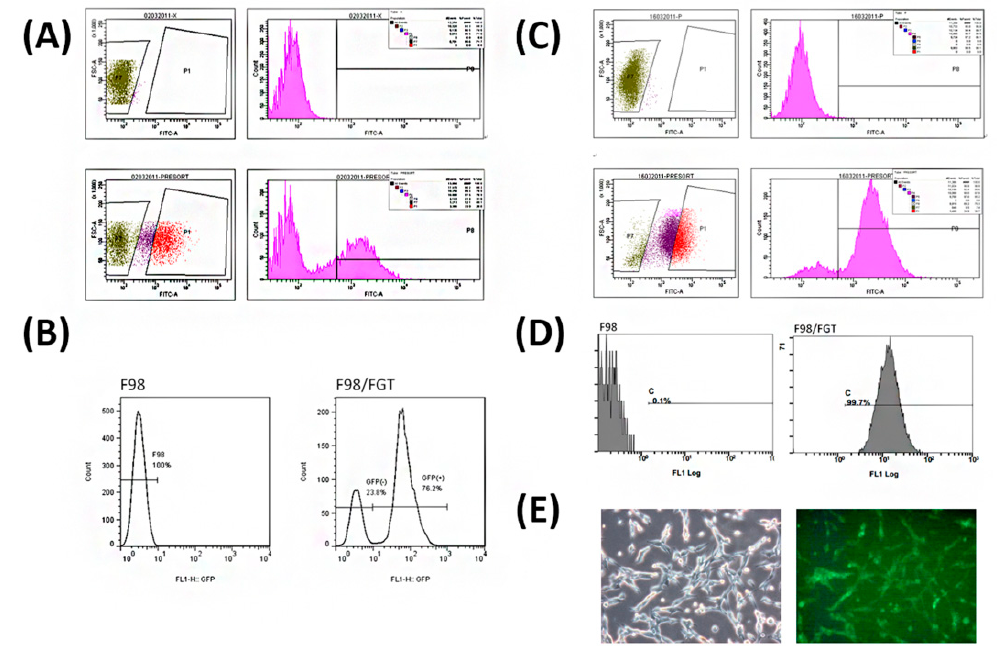
Figure 4. Further sorting of MOI-10 F98 / FGT cells using green fluorescent protein (GFP) reporter and FACScan flow cytometer (FCM) for selection. ( A ) Top left: parental F98 cells were used as the negative control to provide two regions using 2 × 10 5 as the cut-o ff point—P7 for parental F98 cells and P1 for high intensity of green fluorescent F98 / FGT cells. Top right: the green fluorescent intensity (i.e., FITC-A) of F98 parental cells was all less than 2 × 10 2 . Bottom left showed the P7 and P1 for F98 / FGT cells. Bottom right: after four subcultures of F98 / FGT cells from P1 area, those cells in P8 region (the green fluorescent intensity > 5 × 10 2 ) were sorted and analyzed with FCM. ( B ) Flow cytometer analysis showed that 100% of parental F98 cells (left) were GFP( − ), and 76.2% of F98 / FGT cells (right) were GFP( + ). ( C ) The selection protocol as shown in (A) and (B) were repeated to obtain higher percentage of GFP( + ) F98 / FGT cells. ( D ) Flow cytometric analysis showed that 99.7% of F98 / FGT cells were GFP( + ). ( E ) High percentage GFP( + ) F98 / FGT cells were photographed under fluorescent microscope, and it was confirmed that > 90% cells were GFP( + ) (100 ×